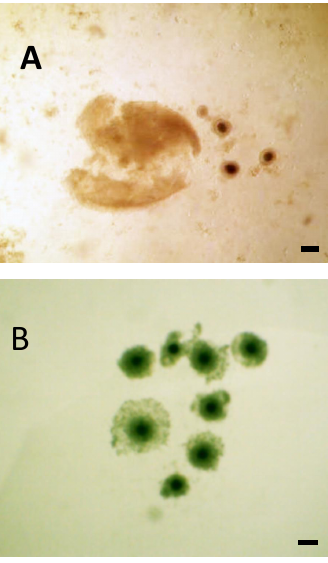
Figure 3. Representative photograph of oocytes from poly-ovular follicles ( A ) many oocytes emerging from a punctured poly-ovular follicle and ( B ) eight oocytes from poly-ovular follicle placed in the culture dish for selection, different sizes and characteristics of the oocytes are observed. Bar = 100 μm , 40× magnification.